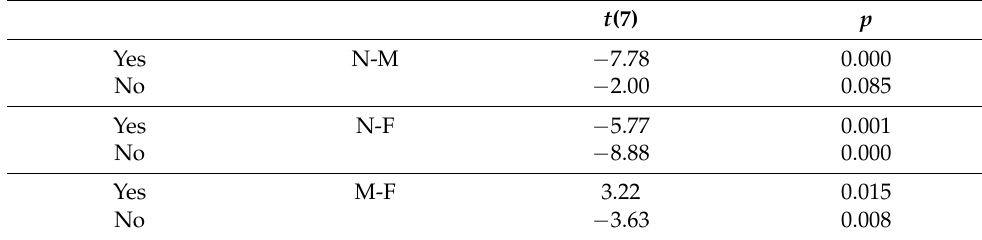
Table 7. Results of dependent samples t -test.